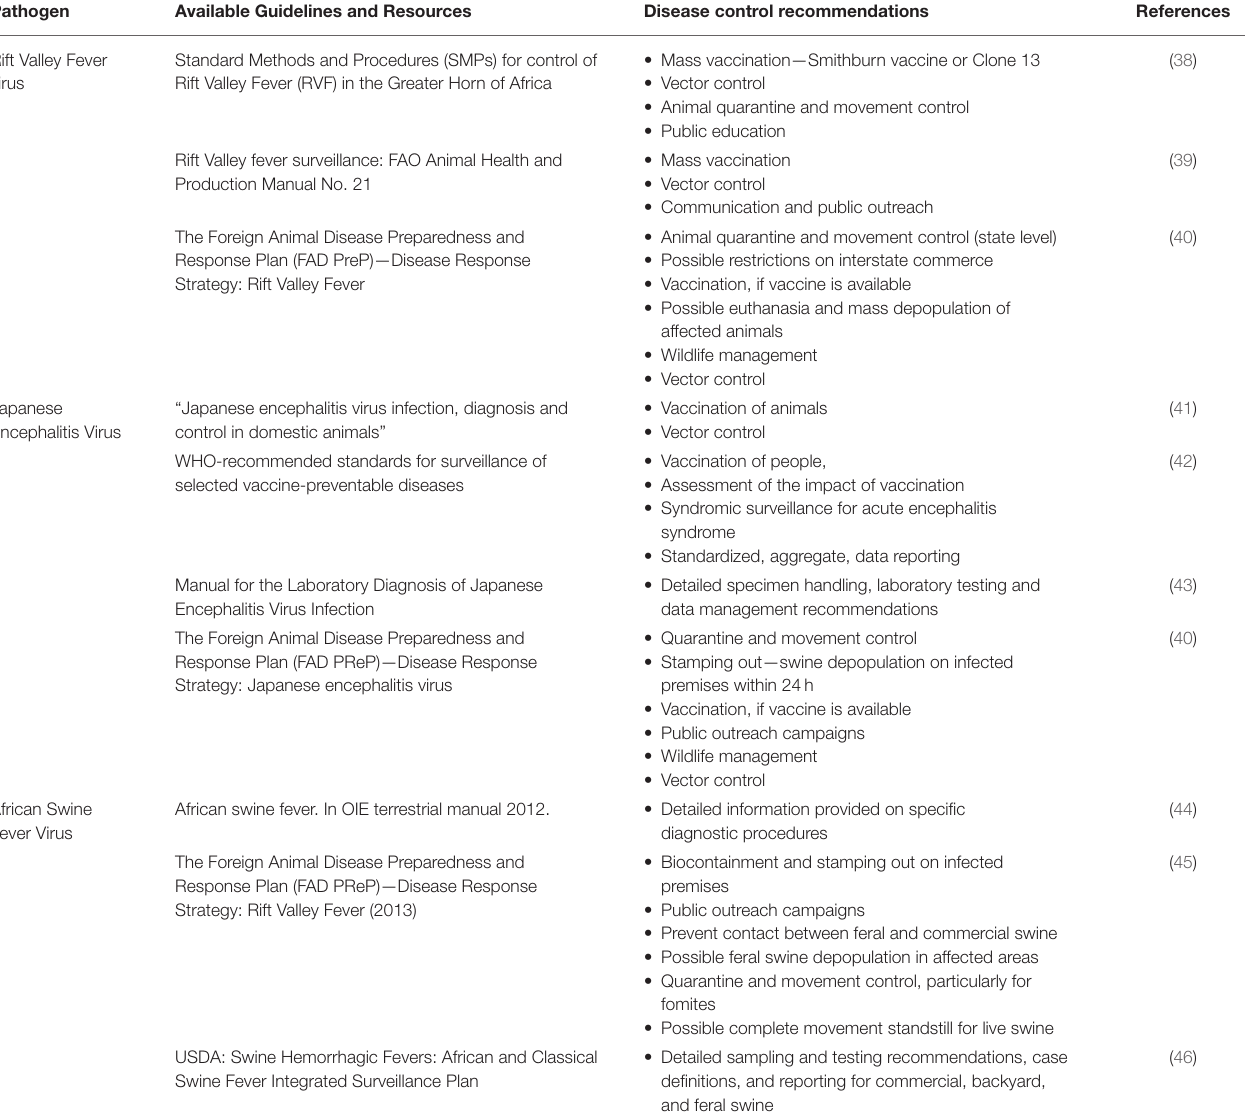
TABLE 2 | Guidelines and control recommendations for Rift Valley fever virus, Japanese encephalitis virus, and African swine fever virus.